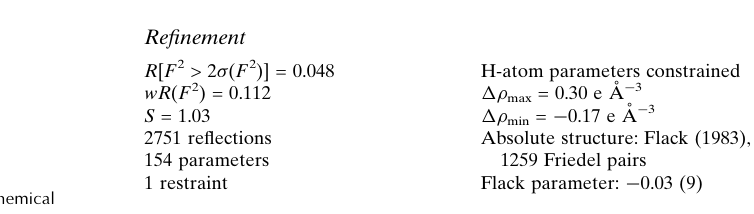
Rigaku Mercury2 diffractometer Absorption correction: multi-scan